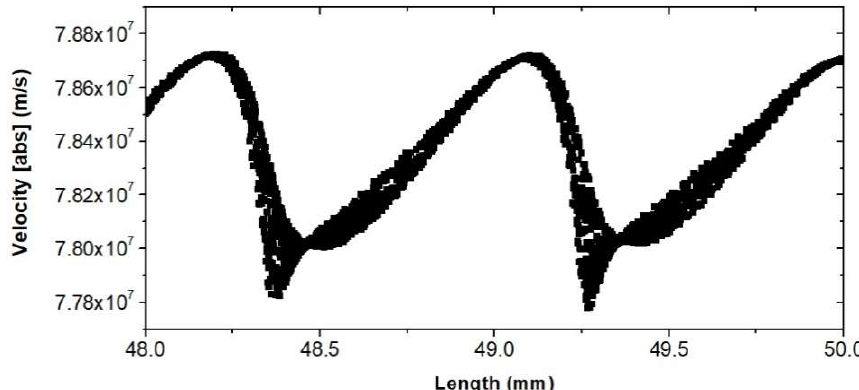
Figure 5. The graph of amplitude of the fourth harmonic.